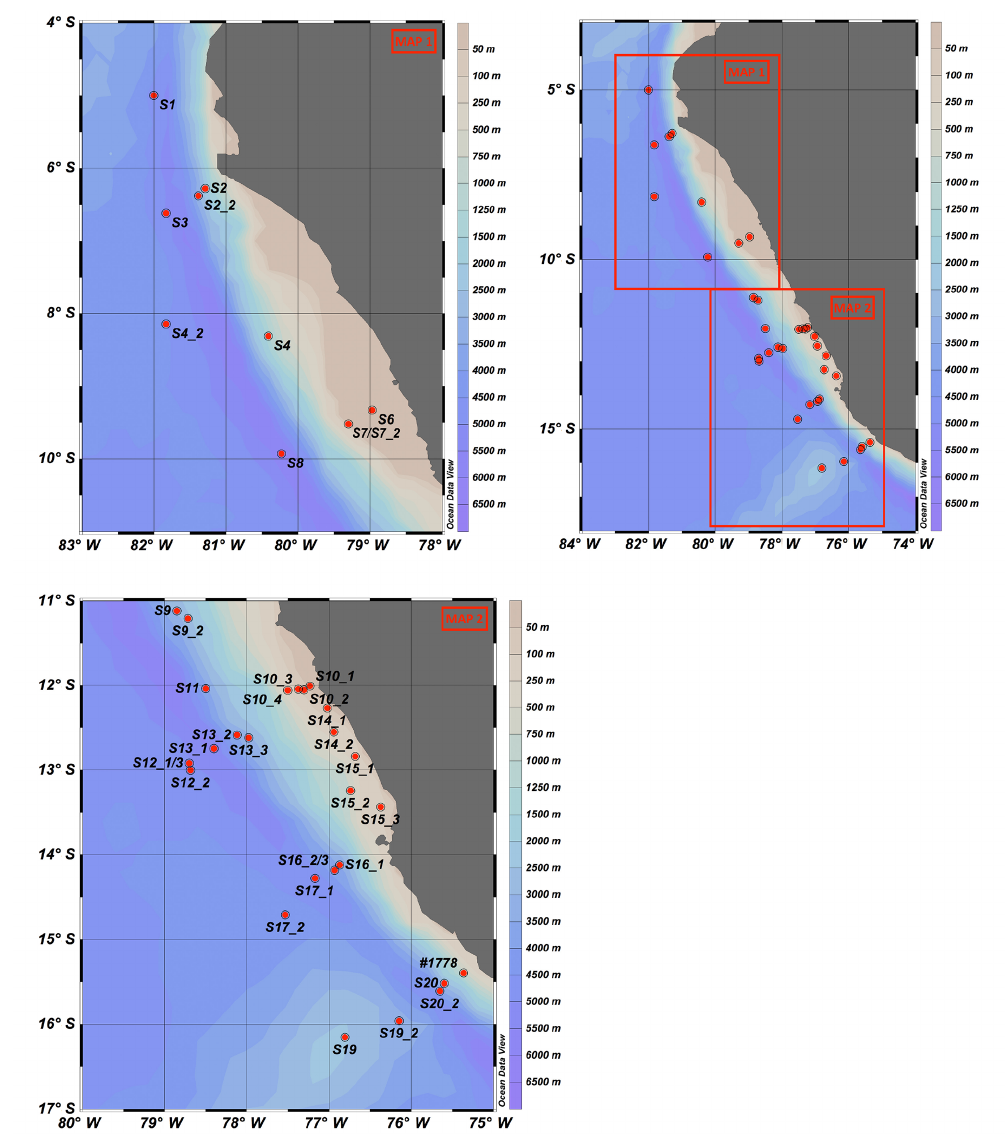
Figure 2. Maps showing all sampled stations. Stations with multiple measurements are: (1) S7/7_2, (2) S12_1/3 and S12_2, (3) S16_1, S16_2/3, (4) S20 and S20_2. The locations of S7 and S7_2; S12_1 and S12_3; S16_2 and S16_3 coincide, as sampling was performed at different